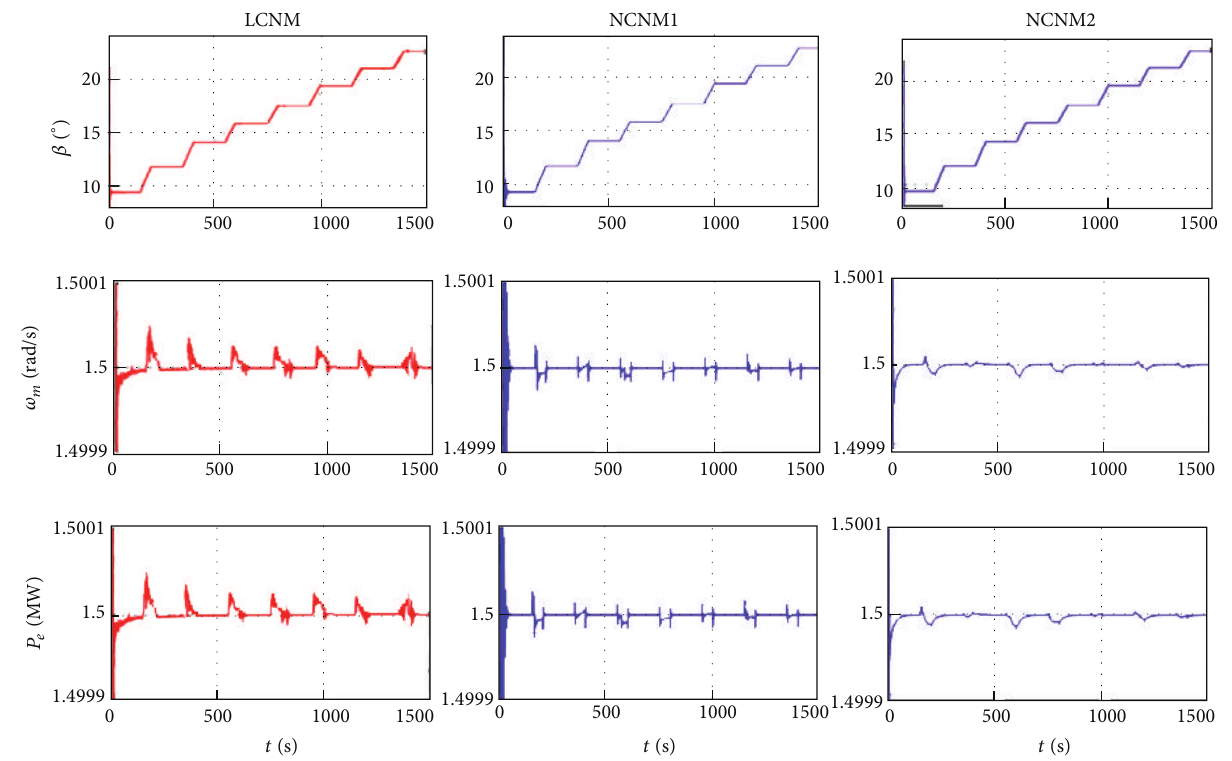
Figure 11: System responses with different pitch controllers in the step wind situation.